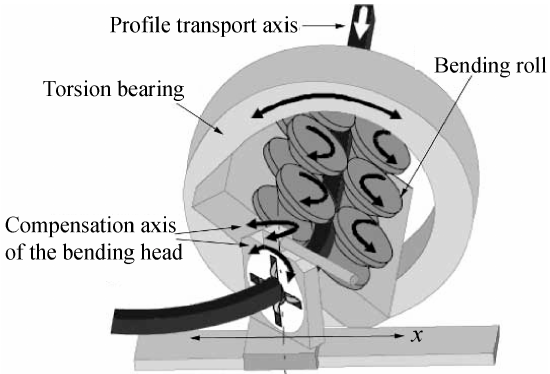
Figure 17. Process of torque superposed spatial (TSS) bending. Reproduced with permission from ref. [65]. Copyright 2010 CIR.